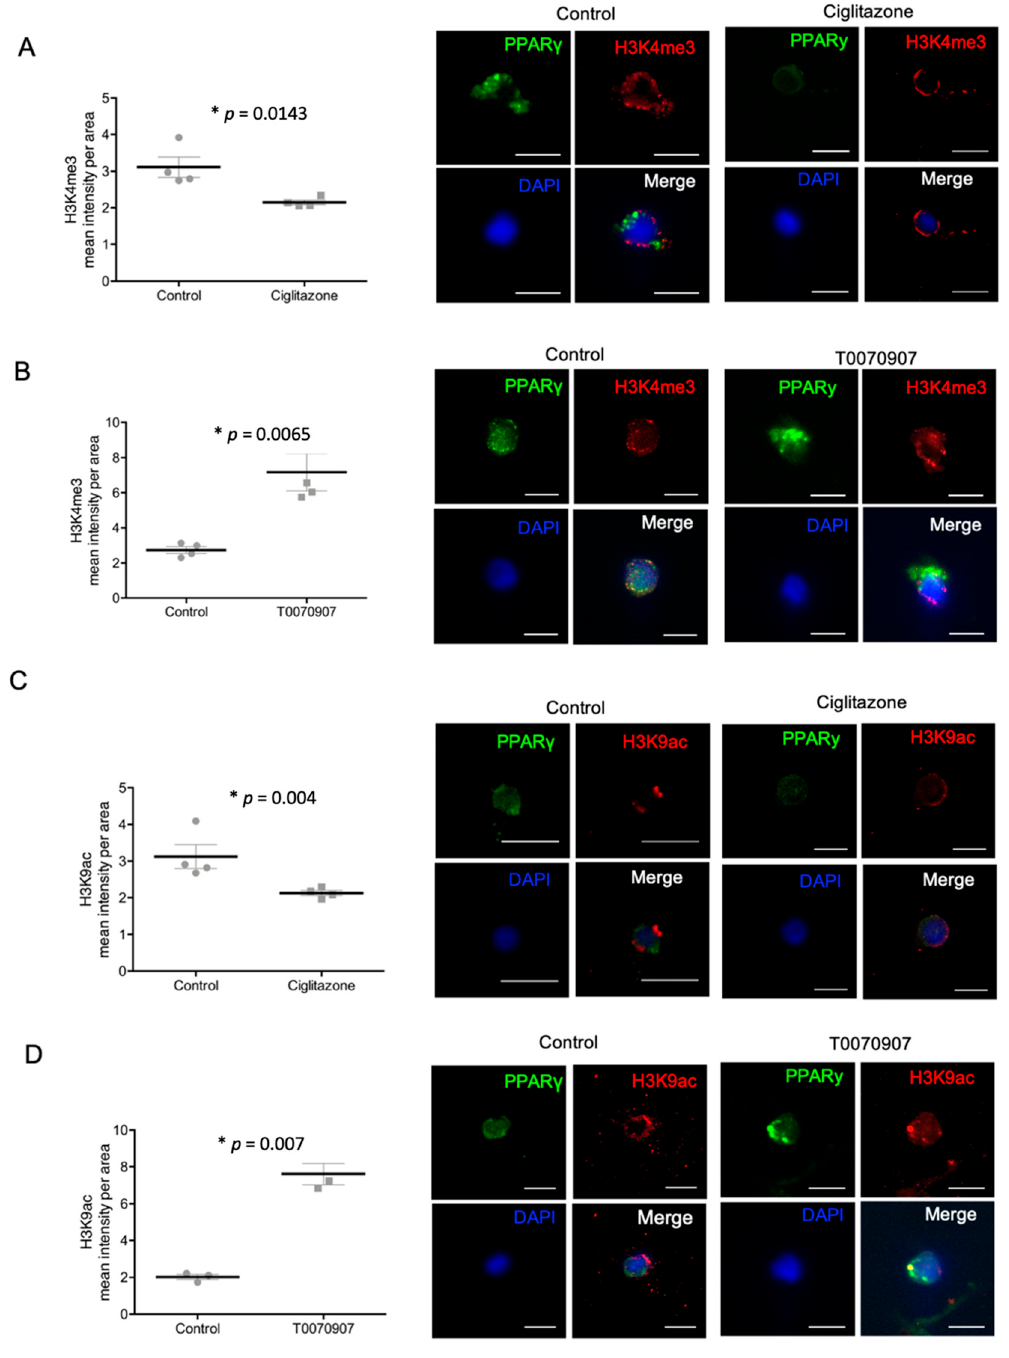
Figure 7. Staining results of histonemodifications H3K4me3 ( A , B )/H3K9ac ( C , D ) and PPAR γ after incubation with Ciglitazone ( A , C ) (20 mM) and T0070907 ( B , D ) (50 mM) mean fluorescence intensity per area, with representative pictures of isolated EVT cells, histone modifications shown in red, PPAR γ in green, DAPI as nucleus staining in blue; Dot plots: mean fluorescence intensity ± SEM. The respective p -value indicates, if the intensity of control cells and cells incubated with Ciglitazone or T0070907 differ significantly and was calculated using the Mann-Whitney-U-Test. Images performed with 10× magnification, Scale bar: 10 µm.